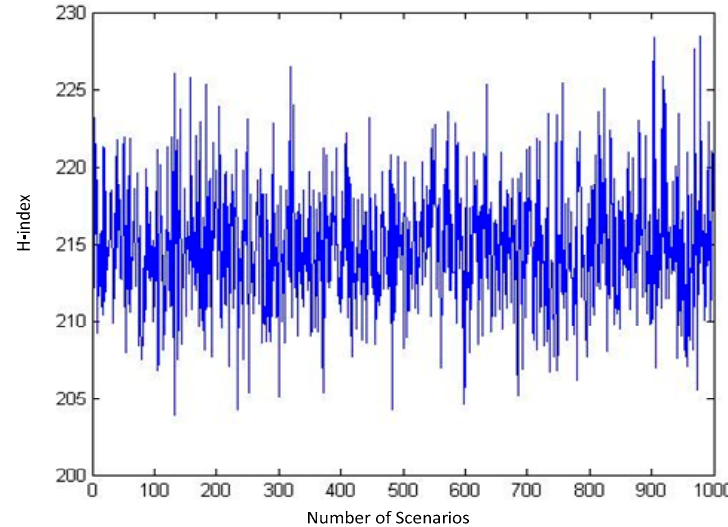
Figure 4. One thousand randomly generated scenarios and their related H-indexes.